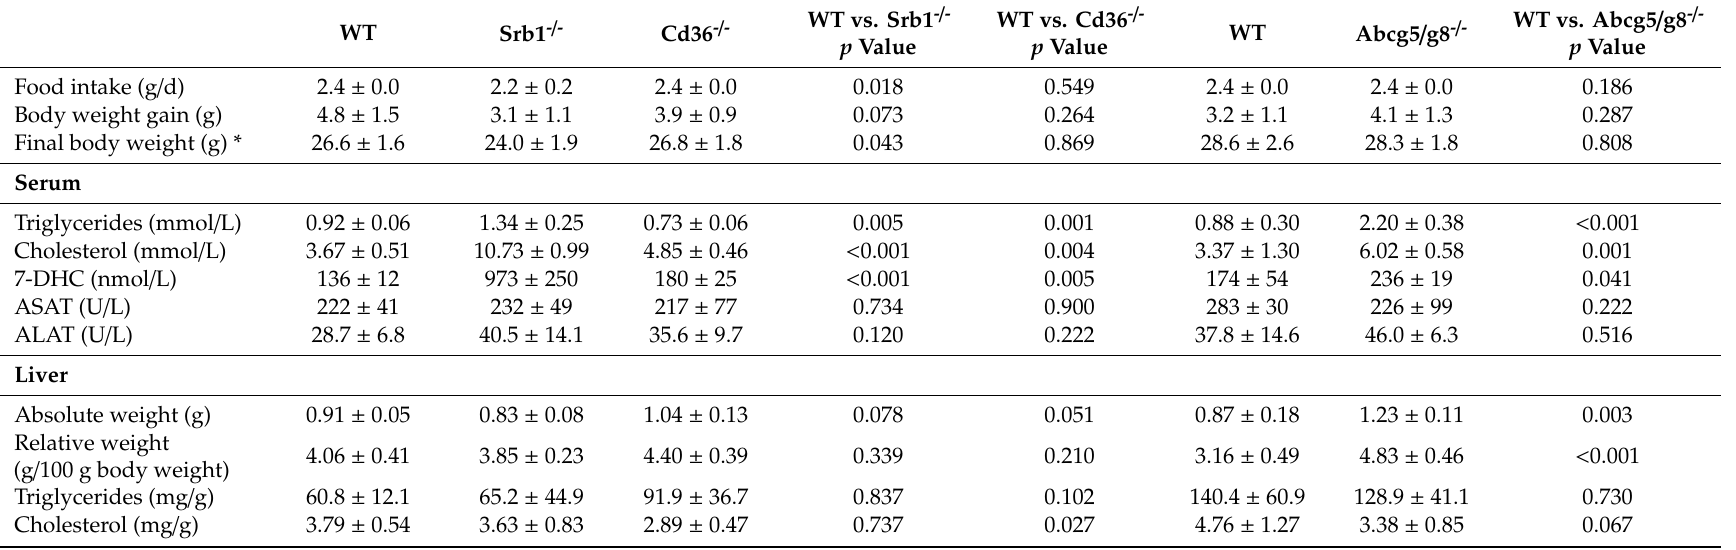
Table 1. Food intake, final body weights, circulating lipids, serum transaminases and lipid levels in liver of SR-B1-, CD36- and ABC-G5 / G8-deficient mice compared to the corresponding WT mice. WT Srb1 - / - Cd36 - /